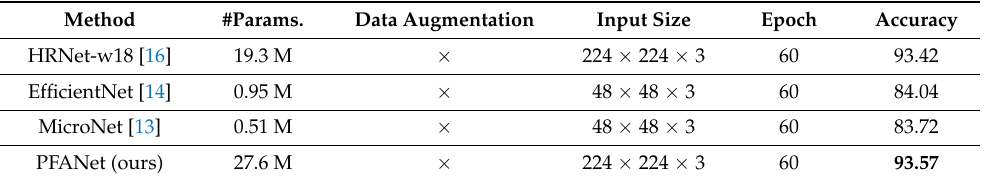
Table 3. The recognition results on ITSRB (proposed dataset).